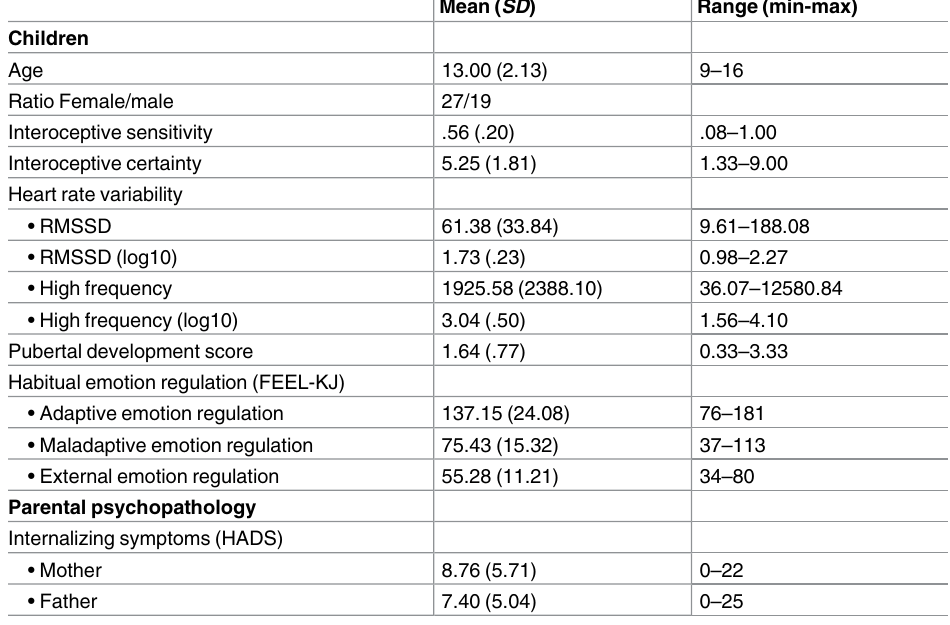
Table 1. Study sample characteristics ( n =